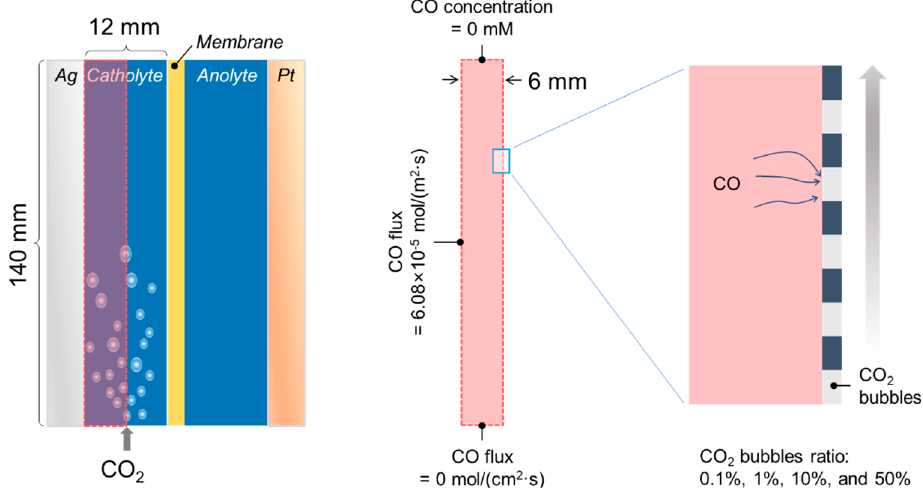
Figure 5. Schematic illustration of the modeling CO transfer for Ag. 2-dimensional modeling (6 mm × 140 mm) was carried on the cross-section of the catholyte chamber. The CO 2 bubbles ratio indicates the proportion of the light gray area. For example, 50% CO 2 bubbles ratio means 50% area of the center plane, which is parallel to the cathode and involves the centerline of the catholyte chamber, is occupied by CO 2 bubbles.